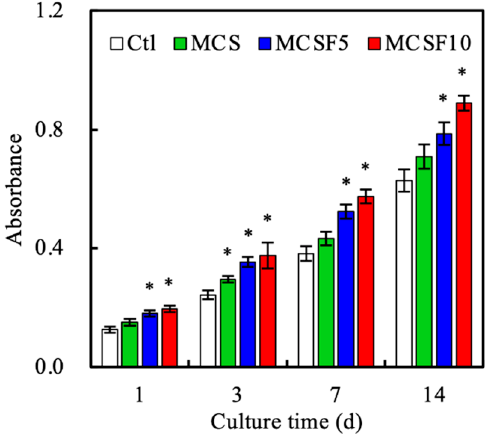
Figure 5. Proliferation of human Wharton’s jelly mesenchymal stem cells (hWJMSCs) cultured on MCS, MCSF5, and MCSF10. * indicates significant difference (p < 0.05) from control (Ctl) group.